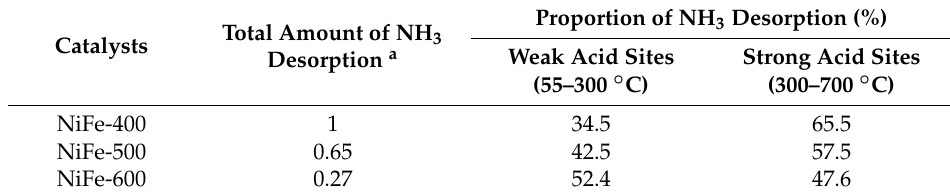
Table 3. The reduction peaks temperature ( ◦ C) and H 2 consumption (mmol g − 1 ) of each catalyst.